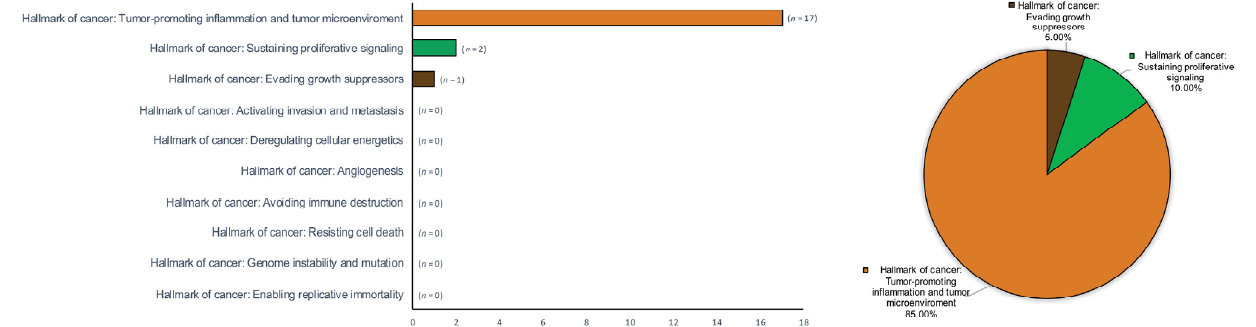
Figure 6. Bar and pie charts graphically summarizing the evidence derived from the research on hallmarks of oral cancer in patients with OLP across secondary-level systematic reviews and meta-analyses. Hallmarks of cancer were ordered by absolute counts (left, bar chart) and relative frequencies by calculating raw proportions, expressed as percentages (right, pie chart).